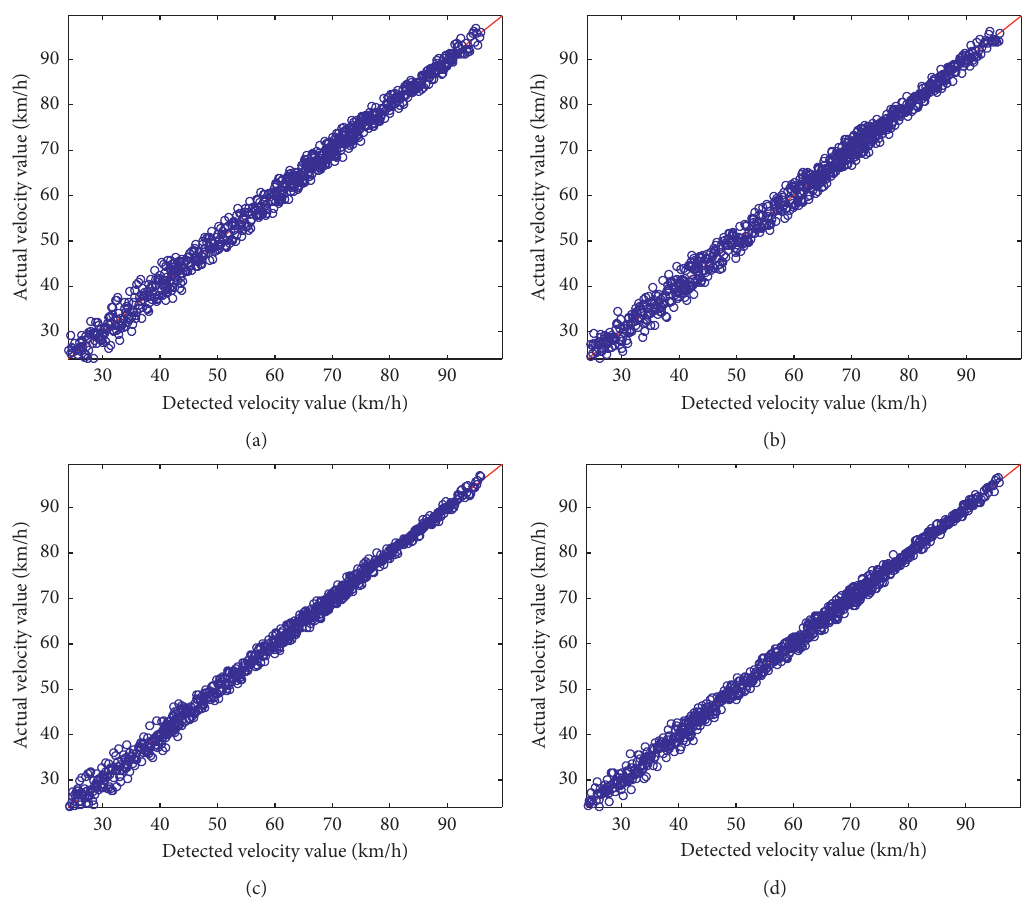
Figure 5: Actual velocity value and the detected velocity value for four different lanes.